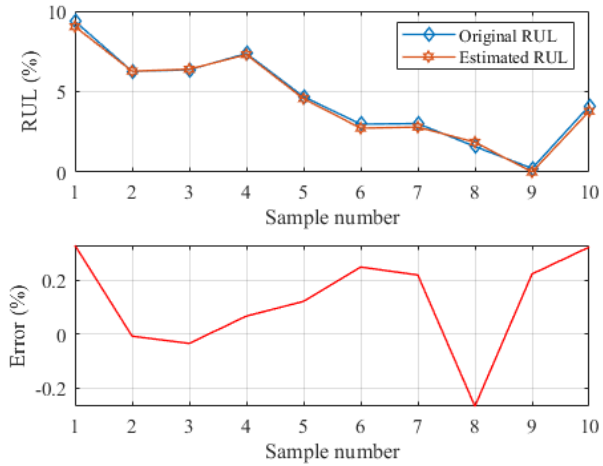
Figure 6. Prediction of RUL using features of feature of PDD (range 3.75–3.5).